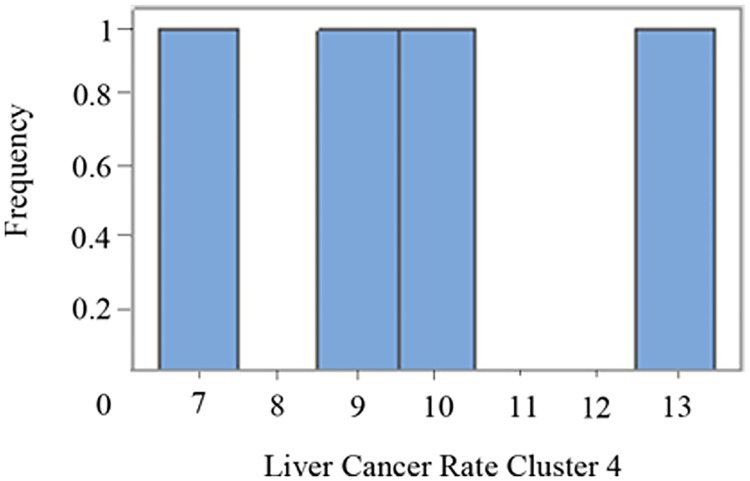
Histogram for liver cancer rate in cluster 4.